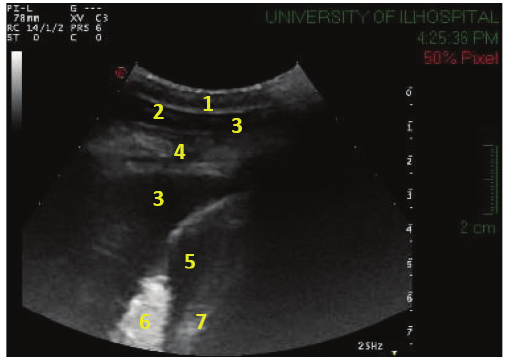
Figure 6: Postmortem image of the thoracic cavity showing severely distended pericardium displacing the lung dorsally and yellow gelatinous material within the pleural